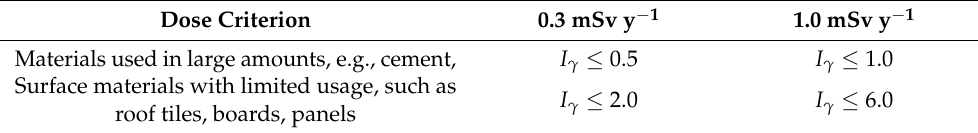
Table 2. Values of gamma radiation activity indices recommended by the European Commission [4]. Dose